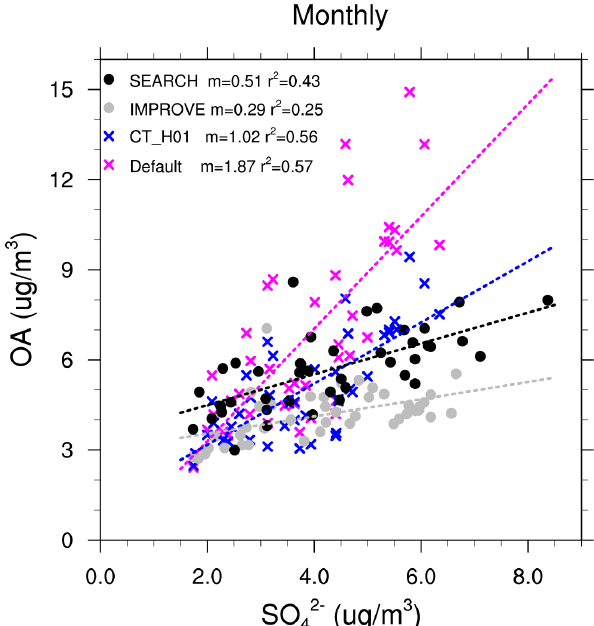
Figure 5. Relationships between monthly OA and sulfate concen- trations (µgm − 3 ). Each dot represents monthly data averaged from all sites from each network within the southeast